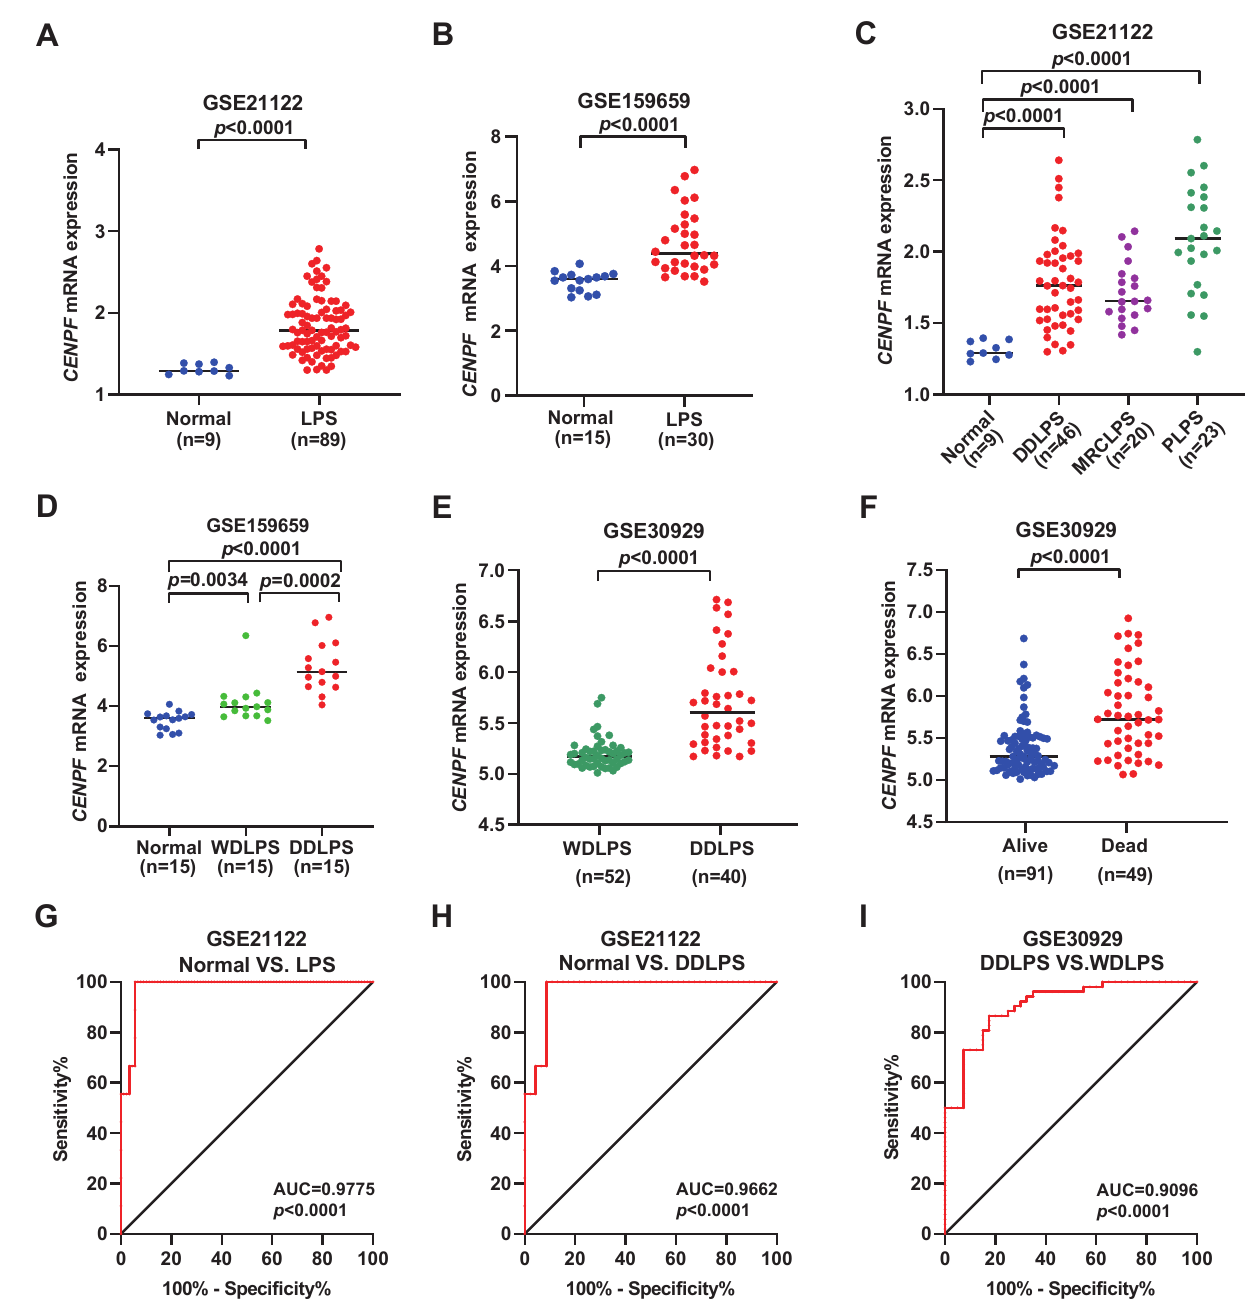
Figure 2. Expression features of CENPF in LPS. ( A – D ) Compared to normal tissues, CENPF expression was upregulated in the LPS of different histological types, including WDLPS, DDLPS, MRCLPS and PLPS. ( E ) Comparison of CENPF expression between WDLPS and DDLPS. ( F ) Comparison of CENPF expression in LPS patients with different survival status. ( G , H ) Sensitivity and specificity of ROC curves of CENPF expression in discriminating LPS or DDLPS from normal adipose tissue. ( I ) The discrimination ability of CENPF expression between WDLPS and DDLPS. LPS: liposarcoma; DDLPS: dedifferentiated liposarcoma; MRCLPS: myxoid (round cell) liposarcoma; PLPS: pleomorphic liposarcoma; WDLPS: well-differentiated